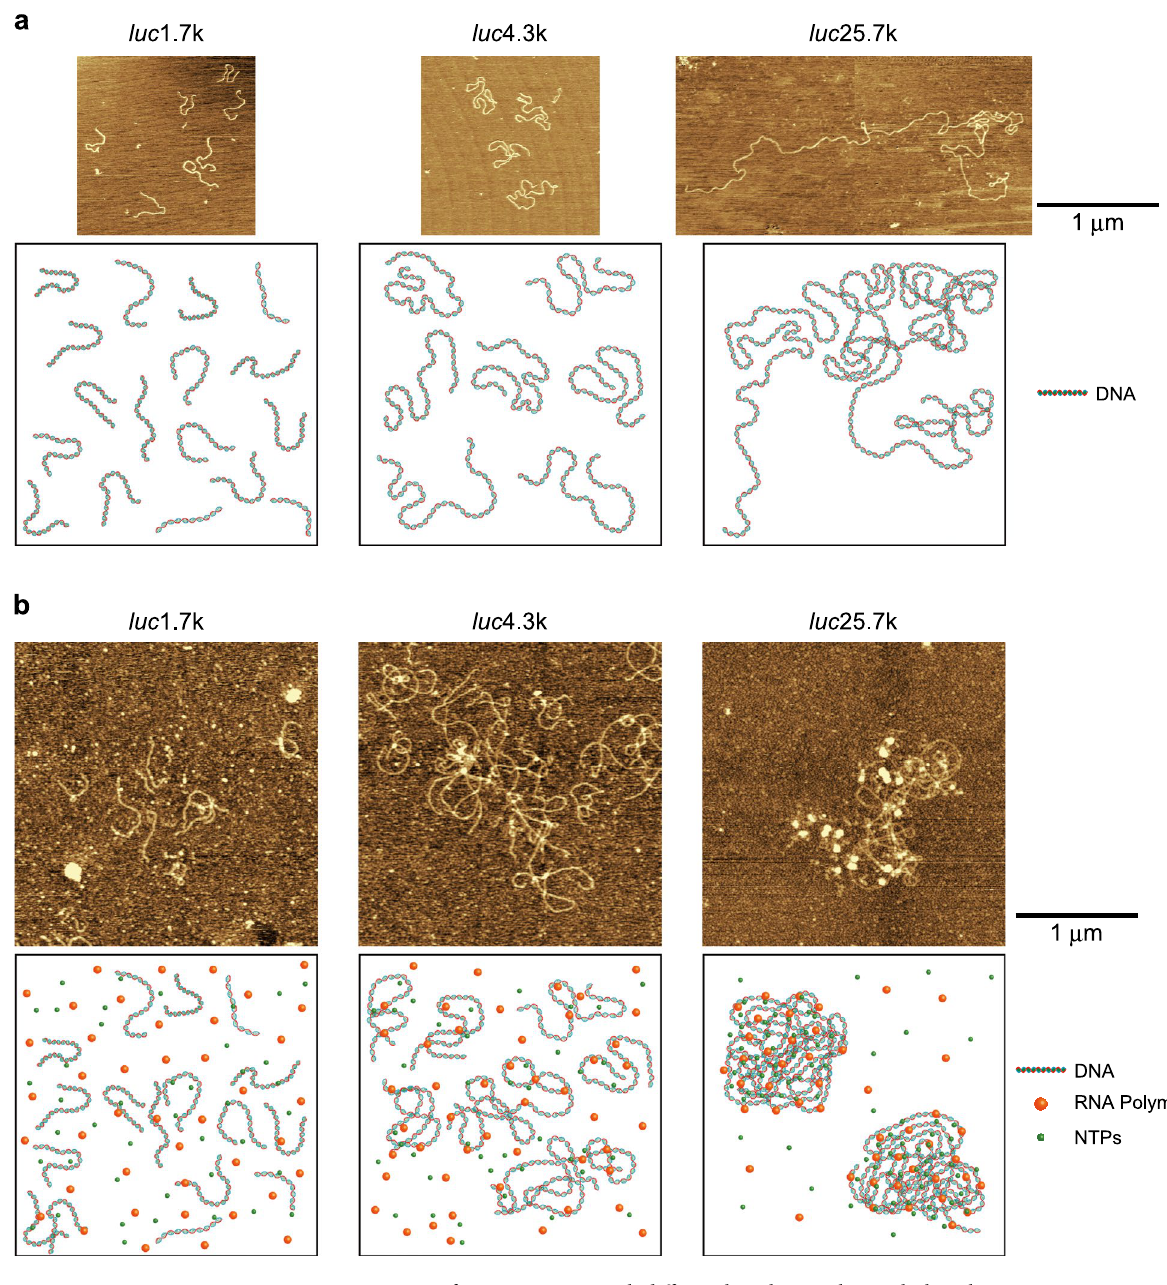
reporter DNA in a 0.05% reaction mixture for in vitro gene